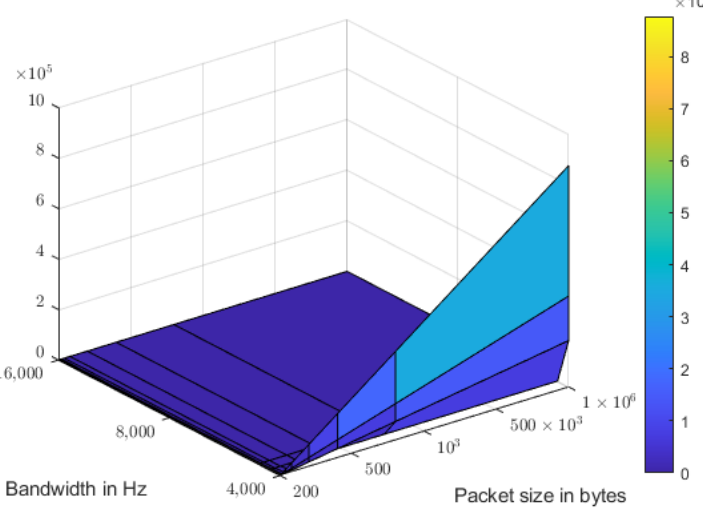
Figure 6. Threshold difference between offloading and local for Relay